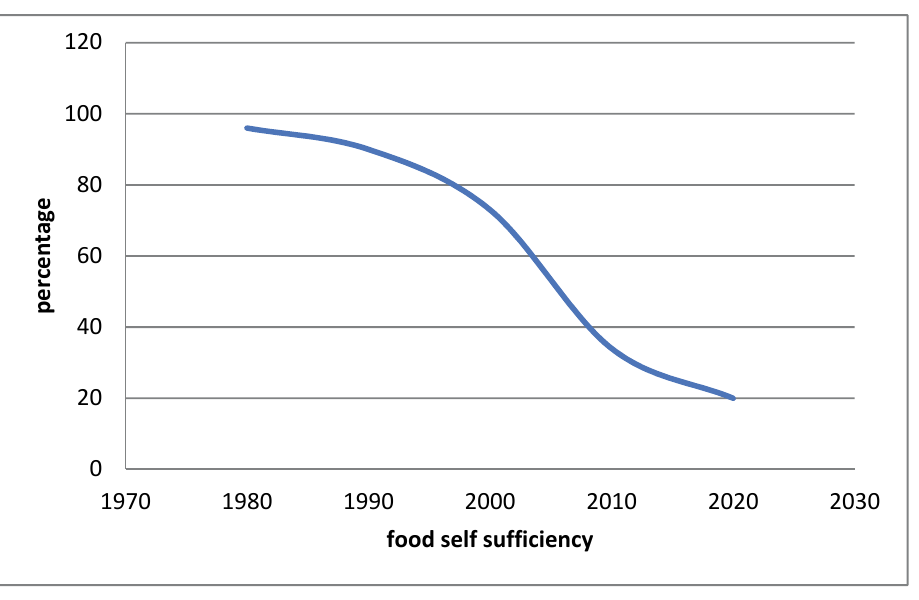
Figure 3. From bread basket to begging